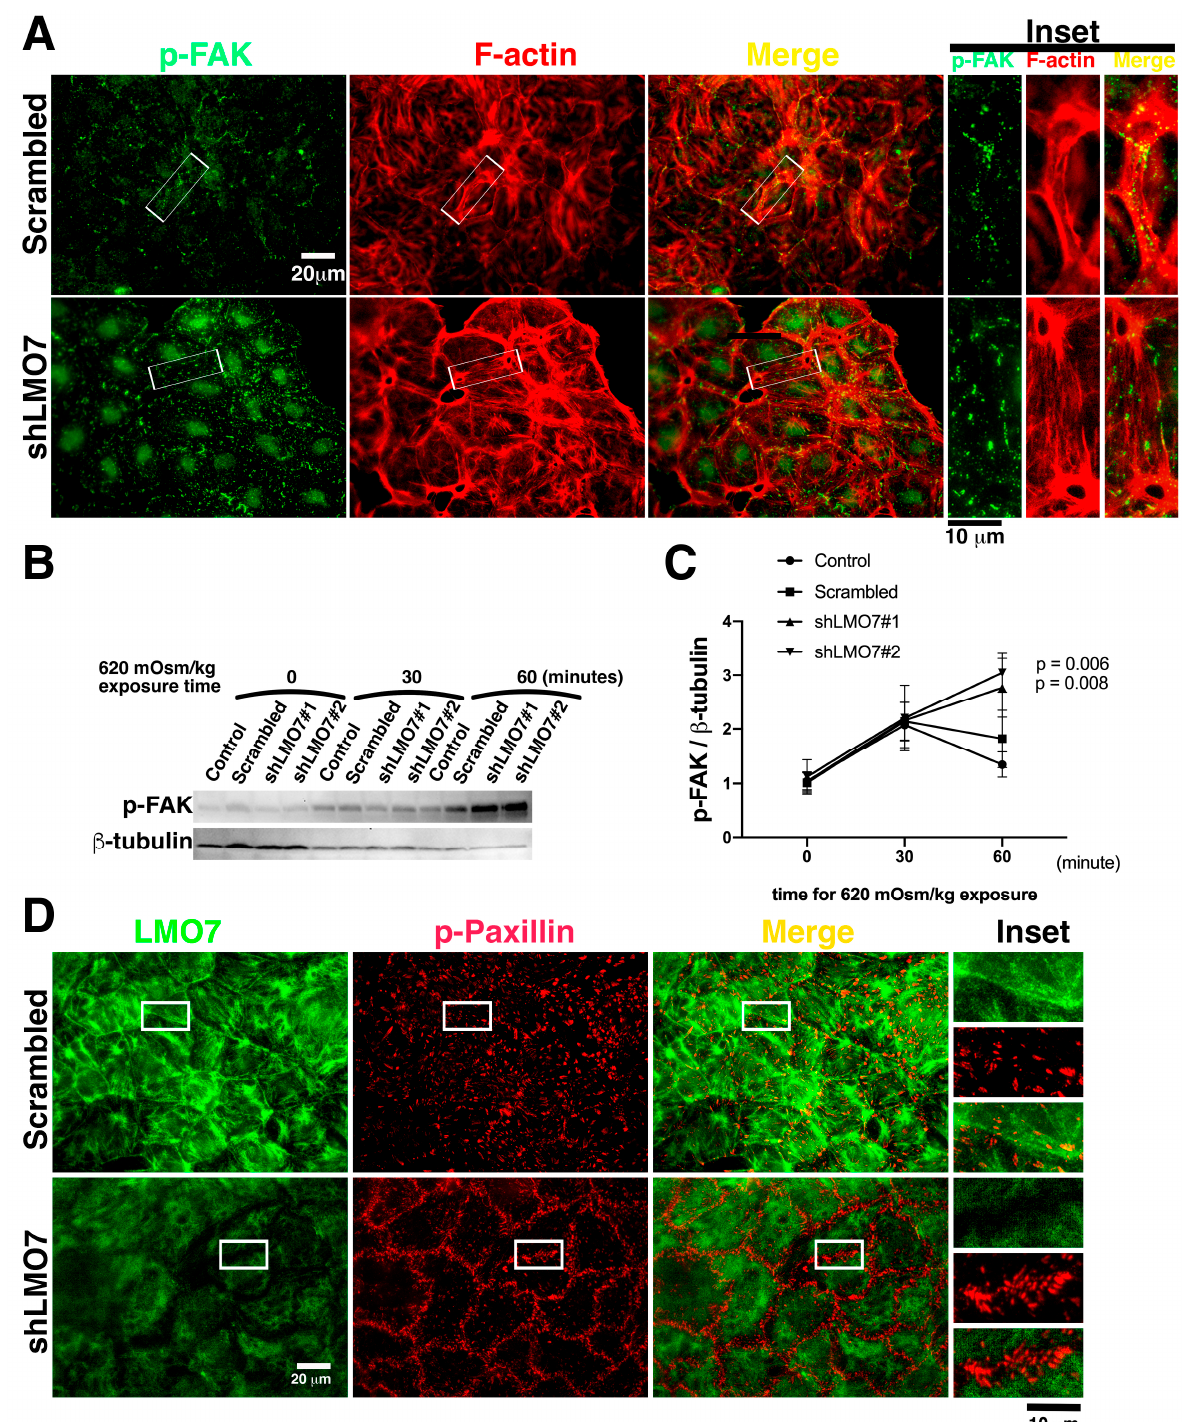
Figure 6. Junctional integrity loss and excessive FAK phosphorylation in LMO7 depleted NRK-52E depleted epithelial sheet, which underwent alternated osmotic challenge. ( A ). The epithelial